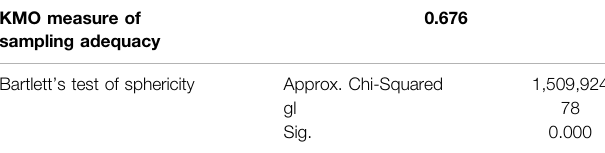
TABLE 3 | KMO measure and Bartlett ’ s test.